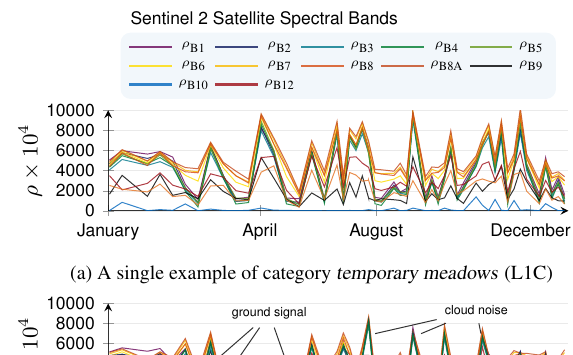
Figure 2. Analyses of the number of parcels and class frequencies per partition in the vector dataset.